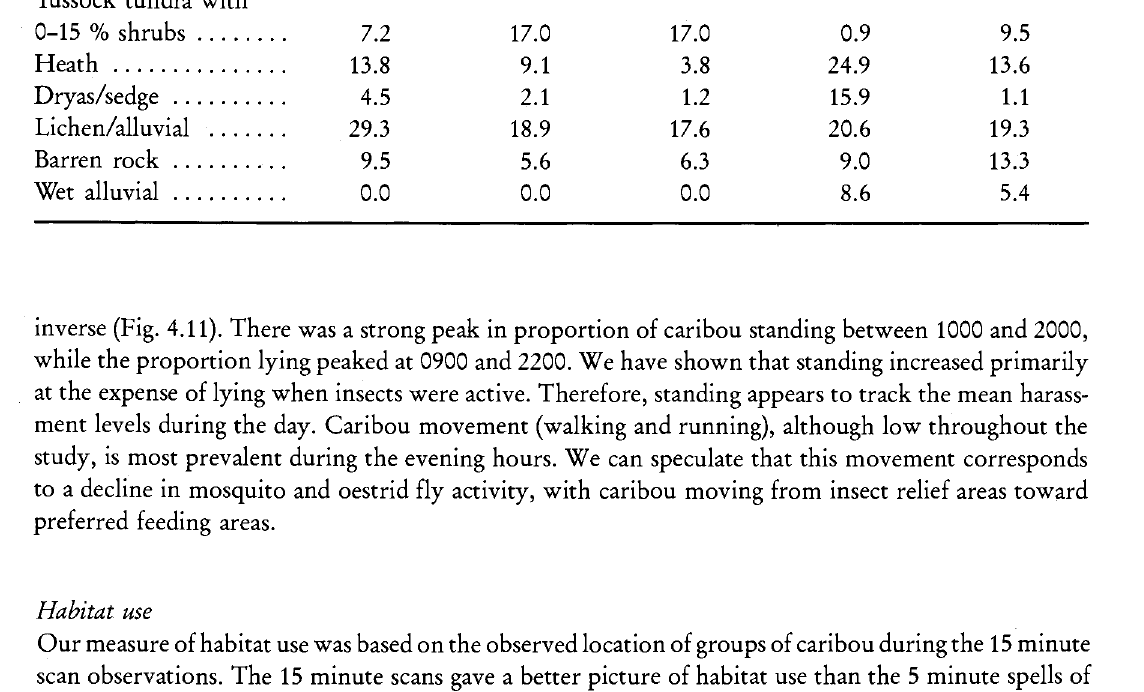
Dryas/sedge Lichen/alluvial Barren rock Wet